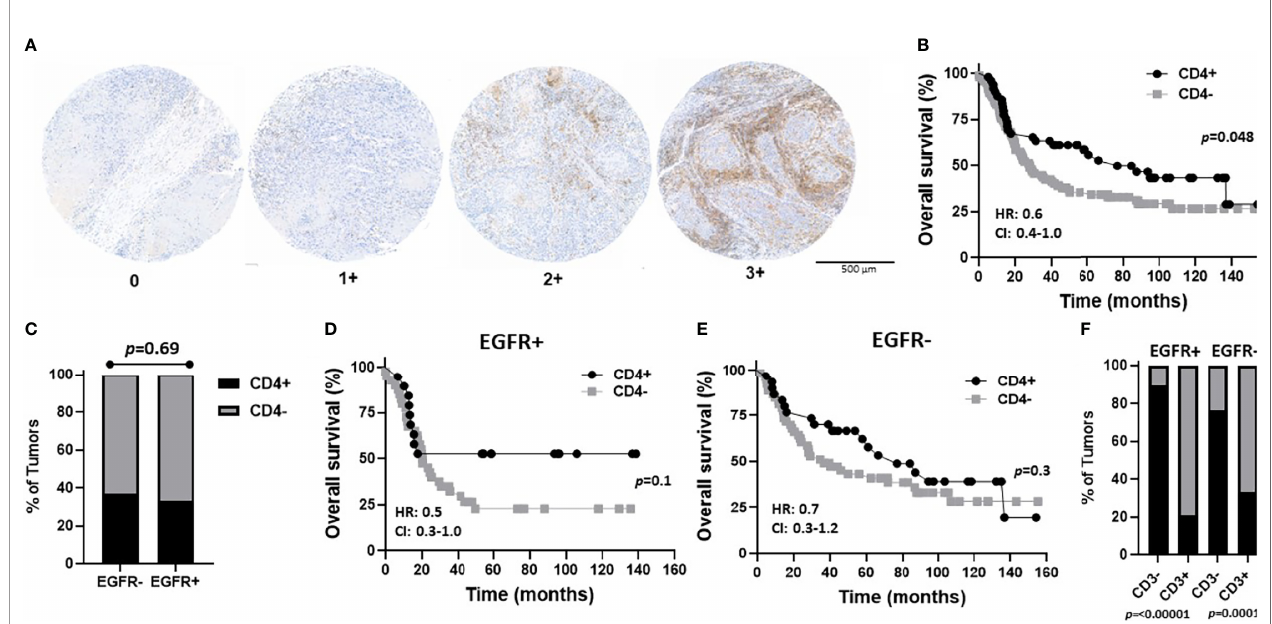
FIGURE 6 | Prognostic impact of combined EGFR and CD4 expression in OSCCs. (A) Shown are images of no [0], low [1+], moderate [2+], and strong [3+] CD4 expression scores. (B) Kaplan-Meier estimates of the overall survival of CD4+ (2+, 3+) and CD4- (0, 1+) patients. (C) Percentages of tumors with CD4+ and CD4- expression based on EGFR status. (D, E) Kaplan-Meier estimates of overall survival of CD4+ and CD4- patients based on EGFR+ (D) or EGFR- (E) tumor expression. (F) Percentages of tumors with CD4+ and CD4- expression based on EGFR and CD3 status. HR, hazard ratio; CI, 95% con fi dence